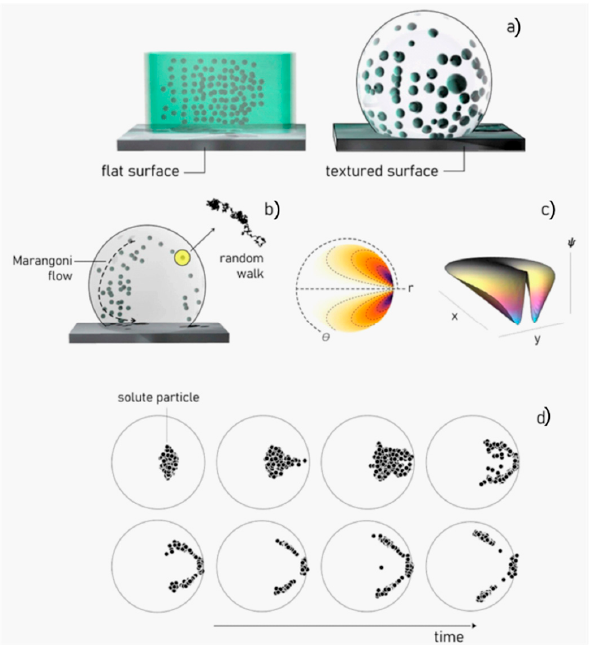
Figure 3. Nanoscale modification of a surface can make that surface super ‐ hydrophobic ( a ). In a drop on a super ‐ hydrophobic surface, the motion of particles is determined by the combination of diffusion and Marangoni convective flows ( b ). The inset reports a graphical representation of the potential functions ψ that describe the velocity field within a spherical drop ( c ). The displacement of particles in a drop can be determined from the velocity field using the Langevin equation and a numerical scheme ( d ).